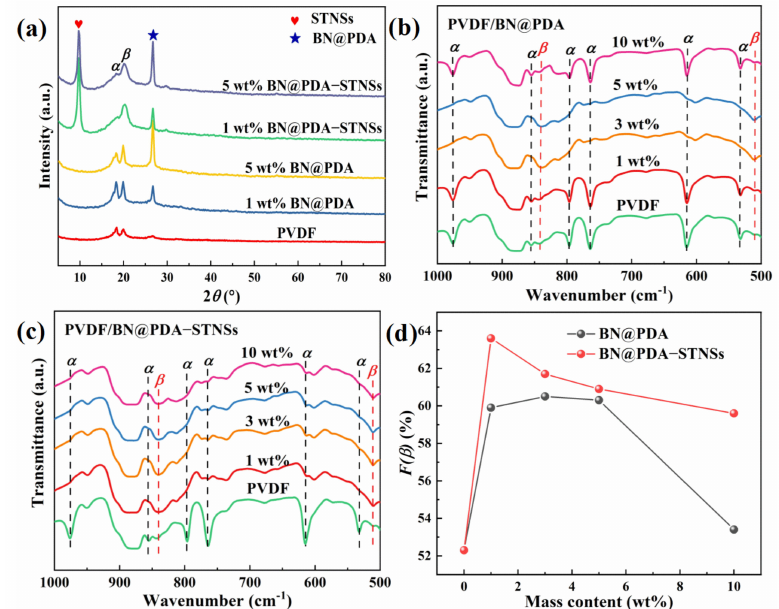
Figure 3. ( a ) The XRD patterns of pure PVDF, PVDF/BN@PDA, and PVDF/BN@PDA − STNSs composites. FTIR spectra of ( b ) the PVDF/BN@PDA and ( c ) PVDF/BN@PDA − STNSs composites. ( d ) F( β ) of pure PVDF, PVDF/BN@PDA, and PVDF/BN@PDA − STNSs